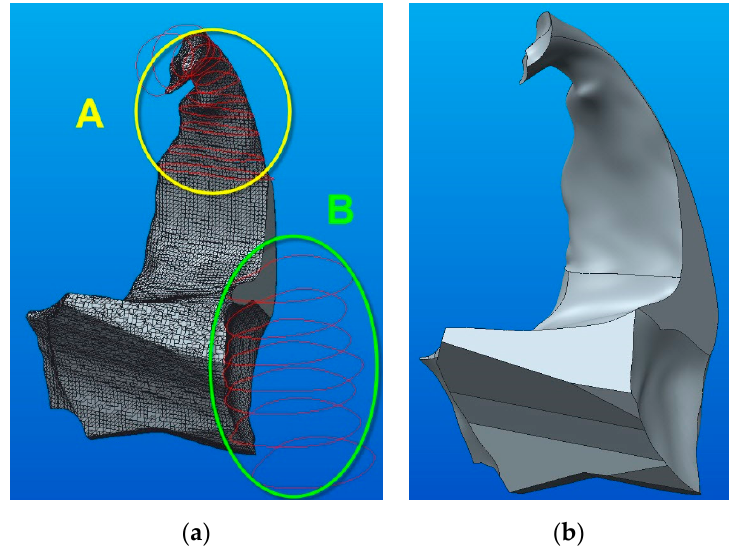
Figure 14. Tracing of the upper and lower part of the B component: ( a ) details of sketches; ( b ) the final parameterized model of the B component.